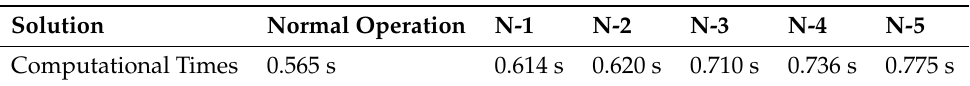
Table 2. Computational times for case studies.